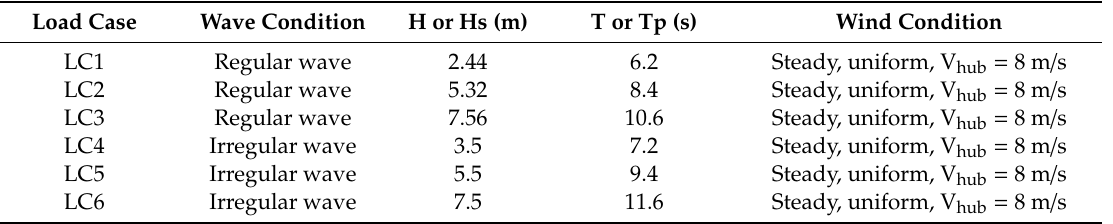
Table 8. Load case